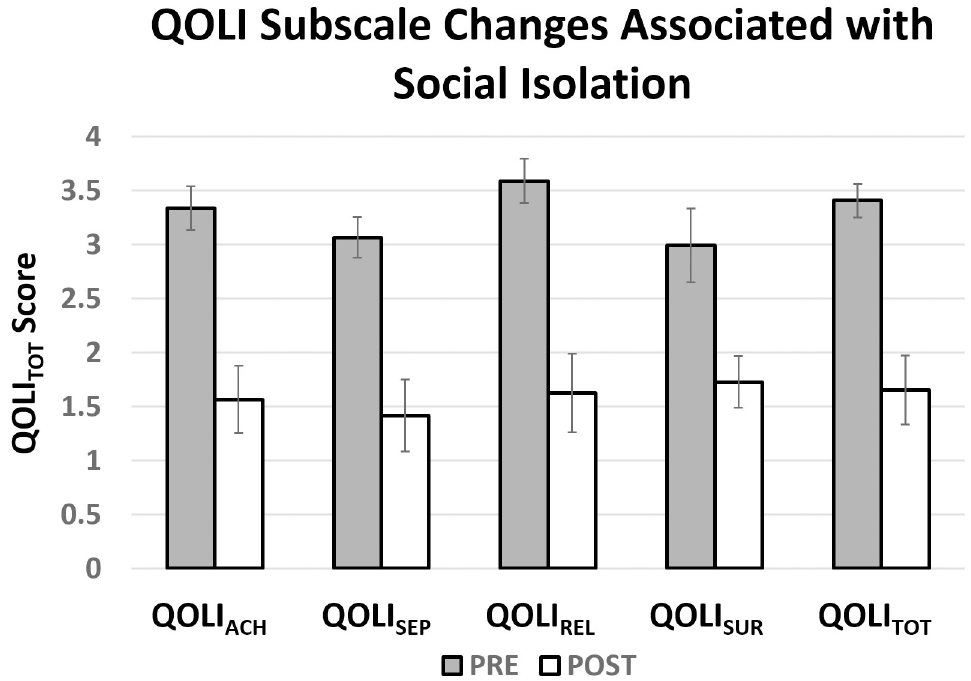
Fig 2. Social isolation related changes in quality of life. Pre- and post-isolation scores on four factors of the QOLI measure. These four factors were identified by O’Cleirigh and Safren [37] (N = 62). Ratings were significantly lower post- isolation for all four factors. QOLI ACH = quality of life related to achievement; QOLI SEP = quality of life related to self- expression, QOLI REL = quality of life related to relationships; QOLI SUR = quality of life related to surroundings; QOLI TOT = quality of life total score.